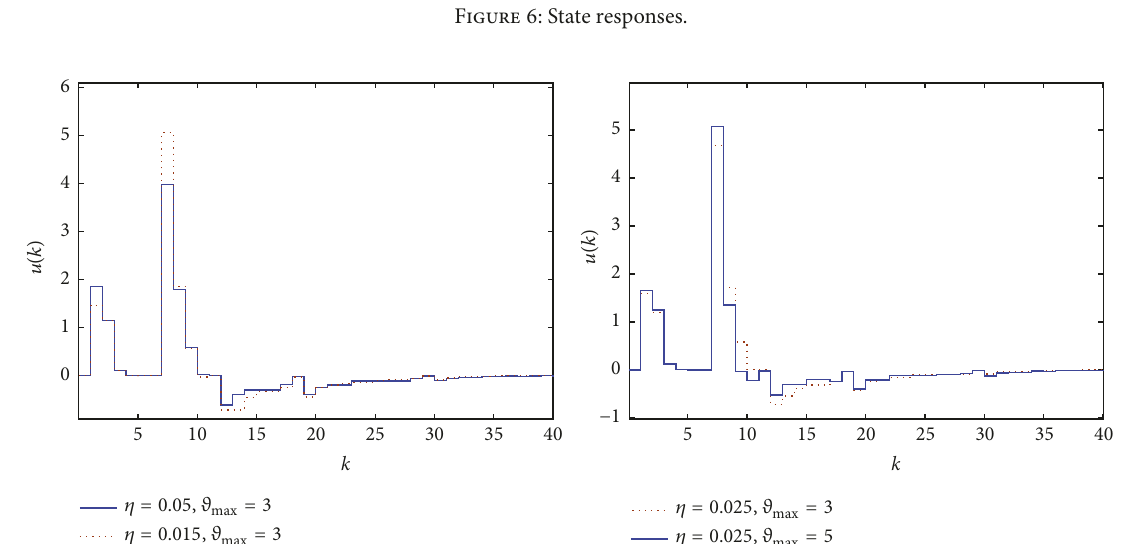
Figure 6: State responses.